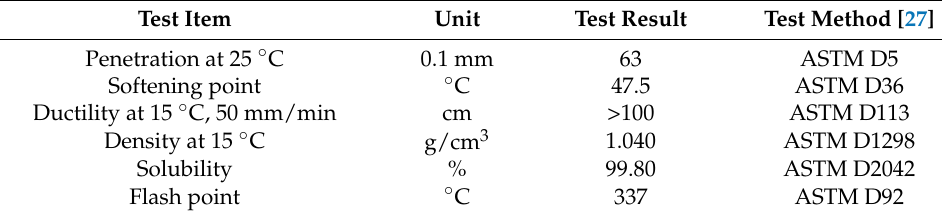
Table 5. Performance parameters of the A-70 matrix asphalt.